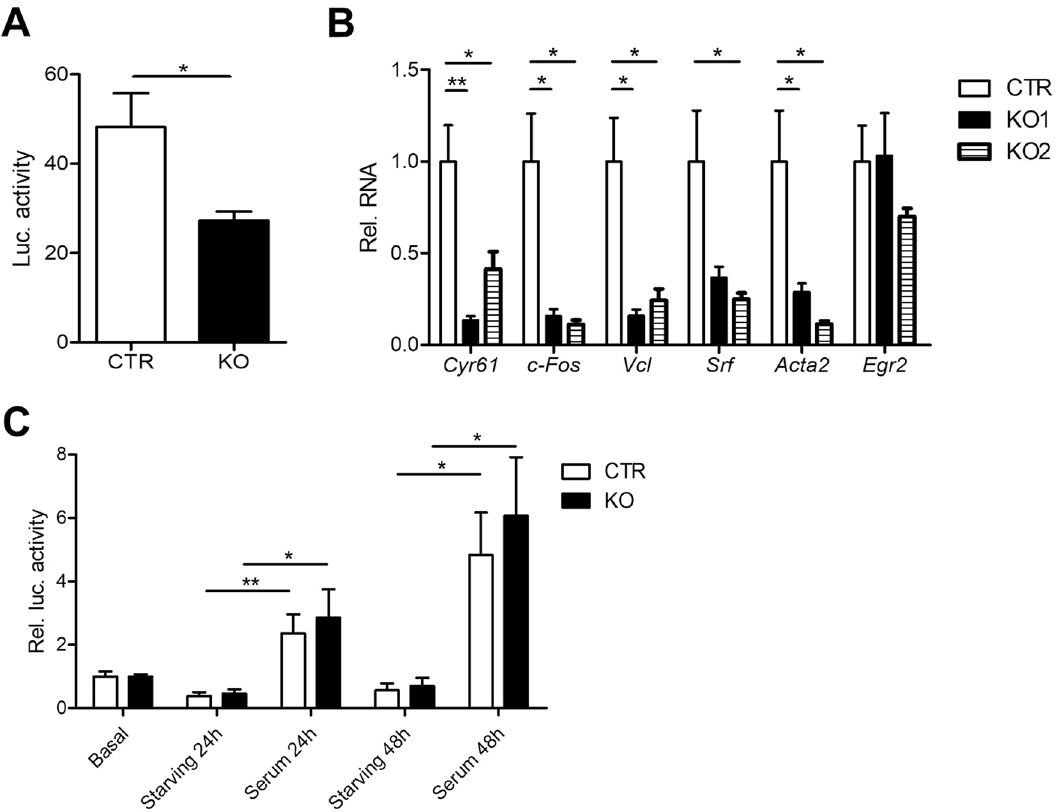
Figure 4. CAP2 inactivation reduced SRF activity in MEFs. ( A ) Firefly luciferase activity in CTR and KO MEFs that stably expressed a SRF reporter in which firefly luciferase expression was under control of SRF activity. ( B ) mRNA levels of selected SRF target genes in two KO MEF lines as determined by qPCR. ( C ) Luciferase expression in CTR and KO MEFs under basal conditions, during starving and upon serum stimulation for either 24 or 48 h. Values are normalized to basal levels. *P < 0.05, **P < 0.01, ***P < 0.001, ns not